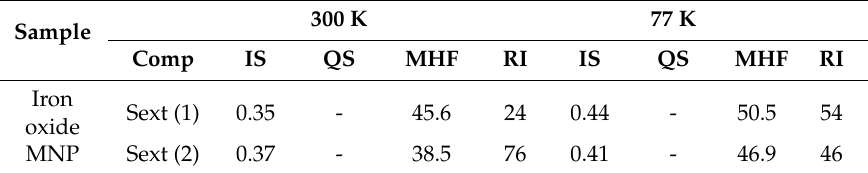
Table 2. Mössbauer parameters of the iron oxide nanoparticles.